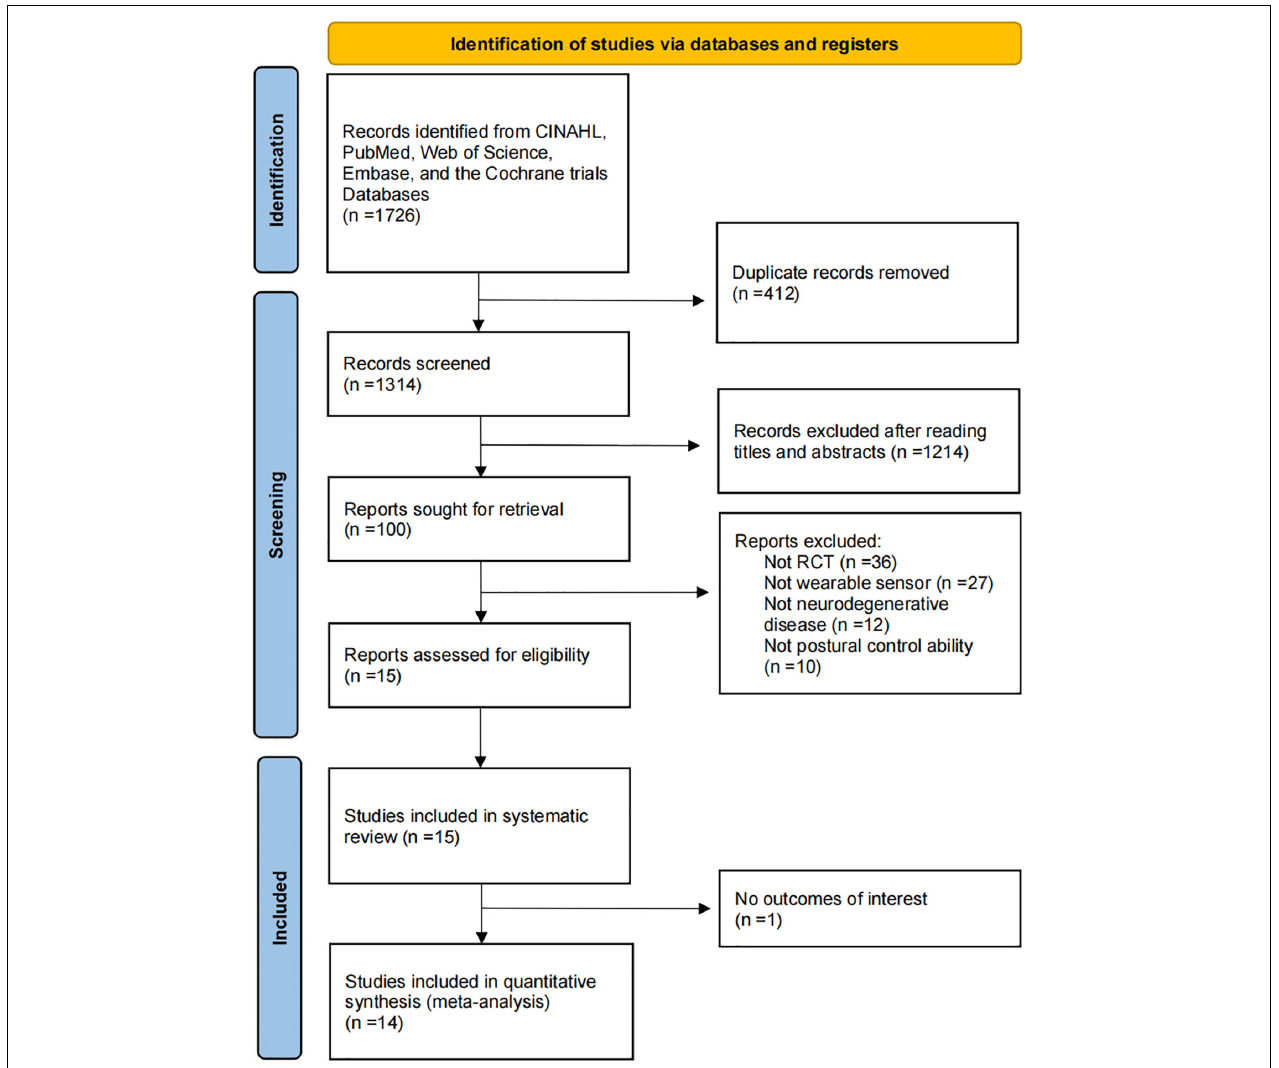
FIGURE 1 | Flowchart of the process of literature search and extraction of studies meeting the inclusion criteria.